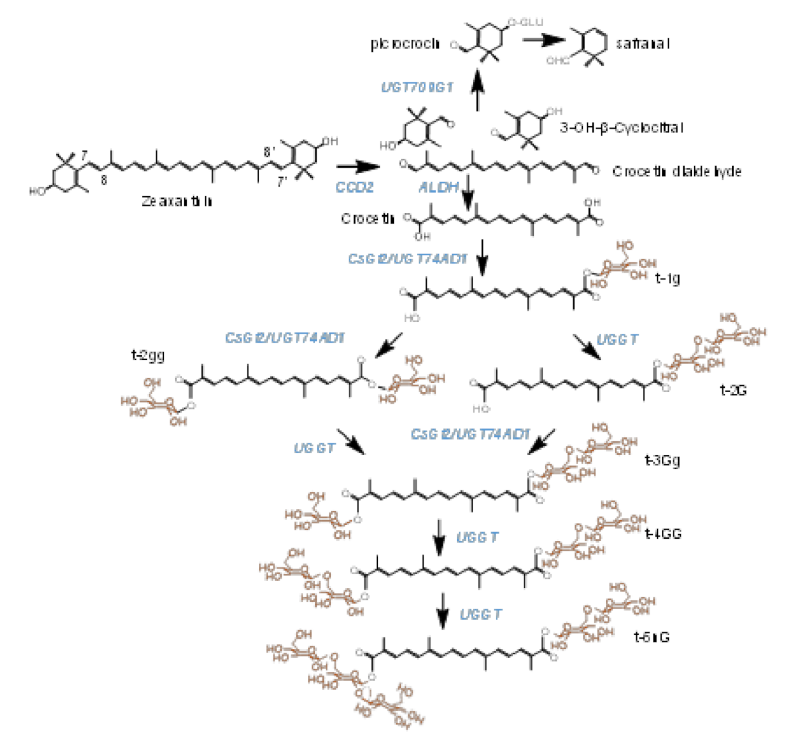
Figure 1. Biosynthetic pathway of crocins in saffron stigmas, from the zeaxanthin precursor. Enzymes catalyzing each step in the pathway are highlighted in blue. The target enzymes in this study are named UGGT. Glucose molecules conferring solubility in water to crocins are highlighted in